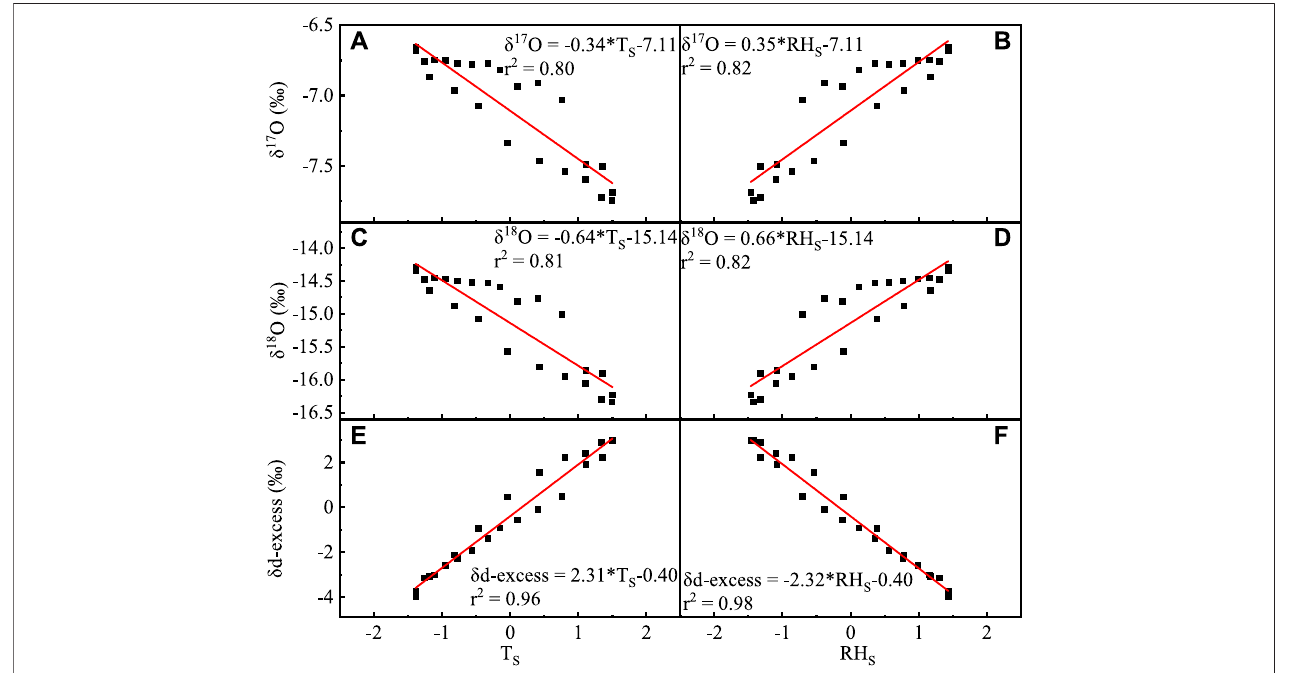
FIGURE 8 | Correlation between monthly average δ 17 O, δ 18 O, and d-excess of the atmospheric water vapor and temperature (A,C,E) , and relative humidity (B,D,1F) (T S stands for dimensionless standard treatment ofthe atmospheric watervapor temperatureand RH S stands for dimensionless standard treatment ofrelative humidity).